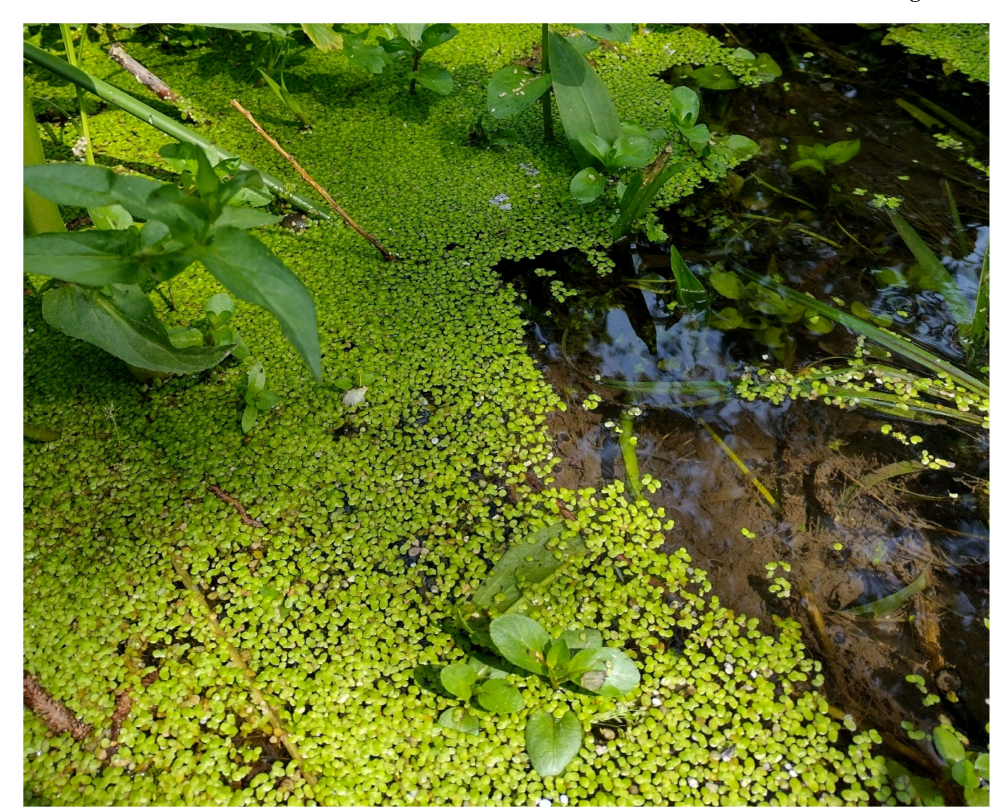
Figure 25. Lemna minuta community, Lemnetea (Acquedotty